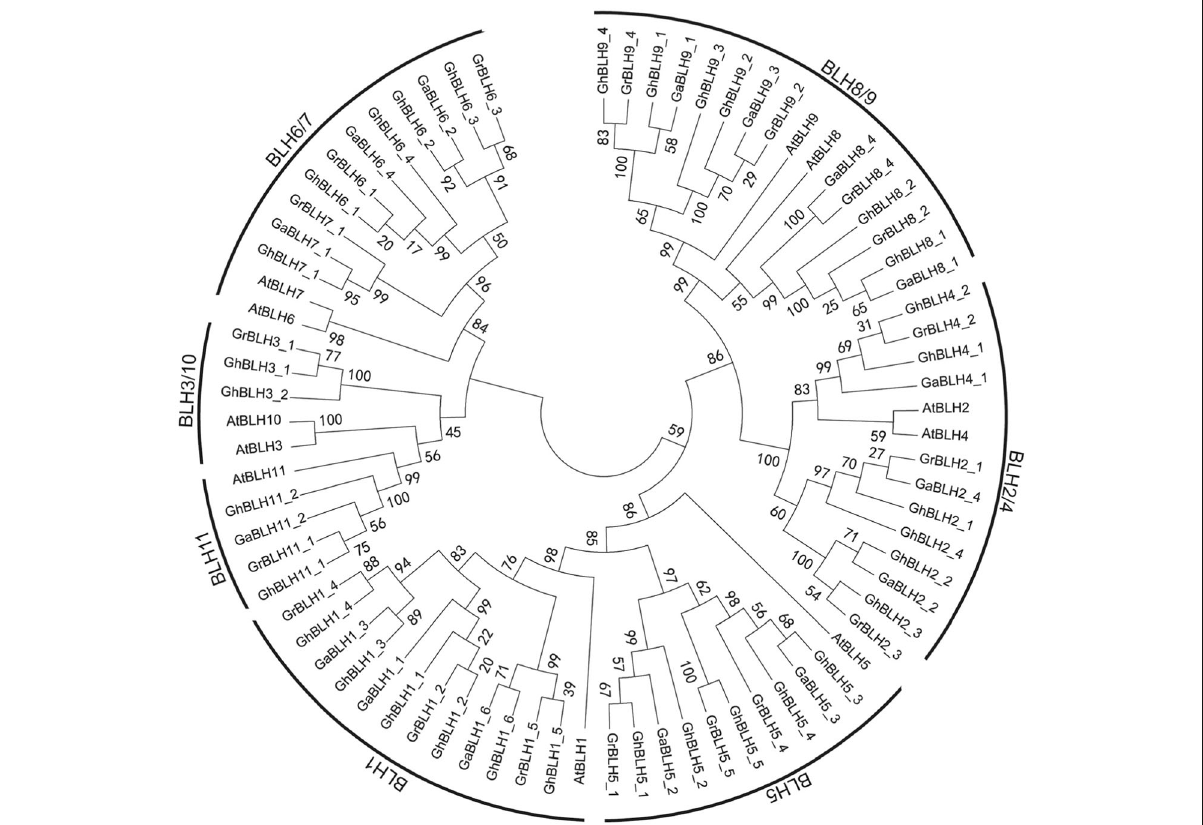
Fig. 1 Phylogenetic tree of the BLH family proteins in G. arboreum , G. hirsutum , G. raimondii , and Arabidopsis. The unrooted tree was generated using the MEGA 6.0 program with the neighbor-joining method. Bootstrap values from 1 000 replicates are indicated at each branch. The phylogenetic trees were constructed based on the full-length protein sequences of the